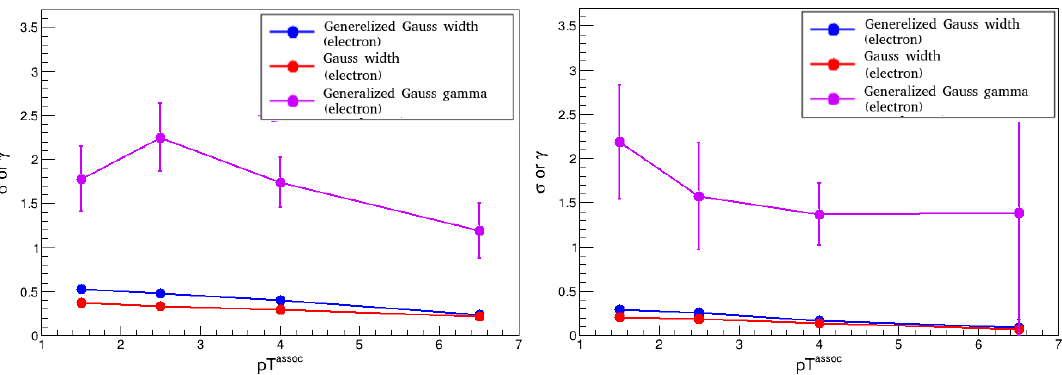
Figure 5. Generalized Gaussian fitting function for electrons from B mesons ( left ) and c quarks ( right ), < 8 GeV/ c and different p assoc for 5 < p trigger T T